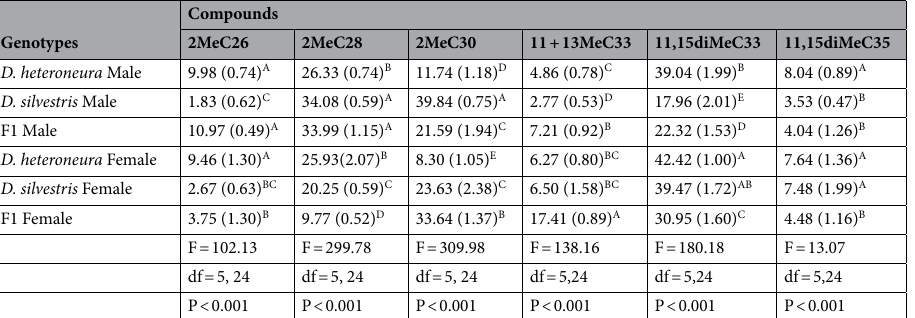
Table 1. Analysis of Variance (ANOVA) of six major CHCs of male and female D. heteroneura , D. silvestris , and F1 hybrids (n = 30 total individuals, n = 5 for each genotype). The mean percentage of each compound is reported for each genotype with the standard deviation in parentheses. For each compound, means that do not share a letter are significantly different following a Tukey’s multiple-comparison test(P < 0.05). Compounds 11 + 13MeC31, 11,15diMeC31, and 11,15diMeC31 were not detected in F1